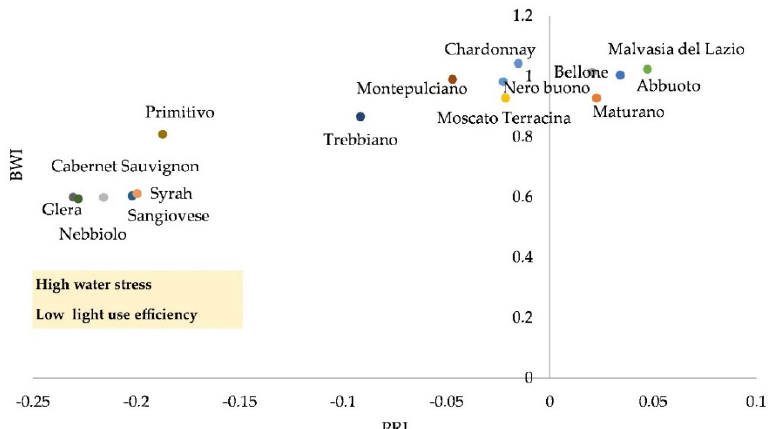
Figure 5. Water band index (WBI) and photochemical reflectance index (PRI): linear and significant correlation for 15 selected varieties. Data refer to the measure at BBCH 091 (after harvest–end of wood maturation).